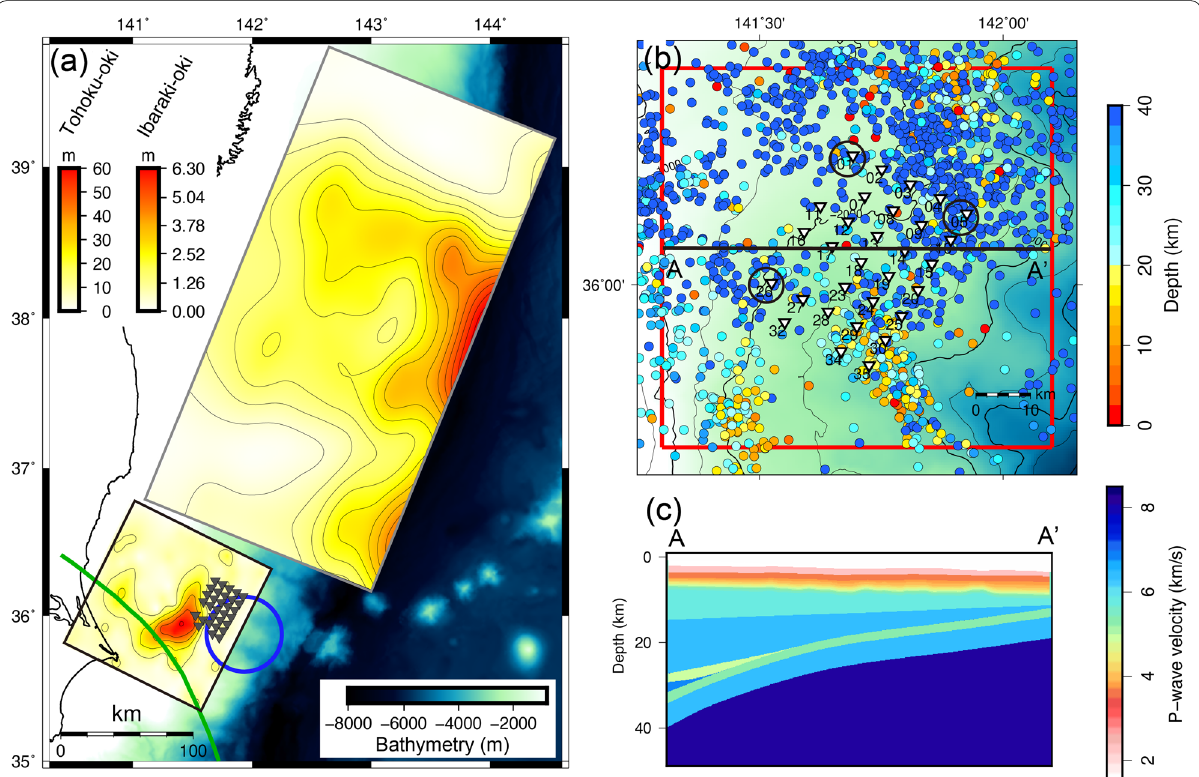
Fig. 1 a Study area with the slip distribution of the 2011 Tohoku-oki earthquake within a grey square (Lay et al. 2011), as well as the 2011 Ibaraki-oki earthquake within a black square (Kubo et al. 2013). The grey triangles show the stations of the OBS array in the of Ibaraki region. The blue circle shows the subducting seamount (Mochizuki et al. 2008). The green line shows the northeastern limit of the Philippine Sea Plate (Uchida et al. 2010). b Distribution of seismicity and OBS stations. The white triangles show OBS stations. The circled white triangles show the stations which were recovered approximately 2 weeks after the 2011 Tohoku-oki earthquake occurred. The colored circles show the earthquake hypocenters determined by JMA with their color indicating their depth. The red rectangle represents the region, where the Green’s functions were calculated. c Seismic velocity structure model along profile A–A’ in b . The region shallower than ~ 10 km was constructed by Yamaya et al. (2021), and deeper by Koketsu et al.